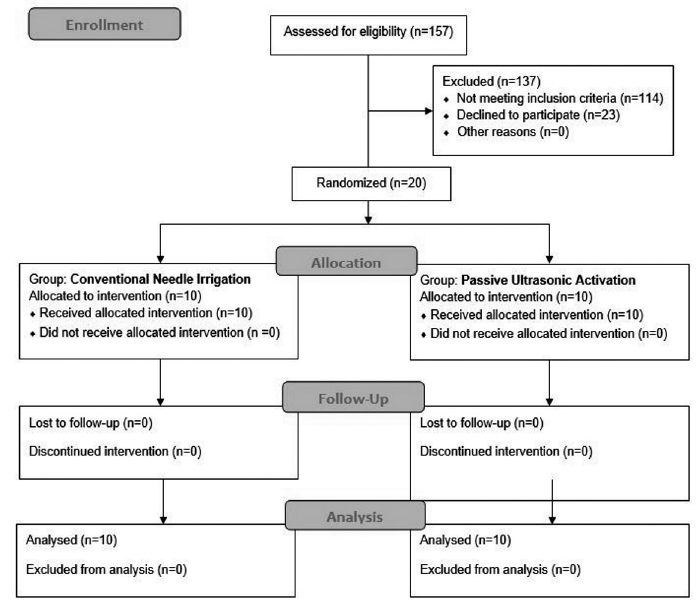
Figure 1- CONSORT flow